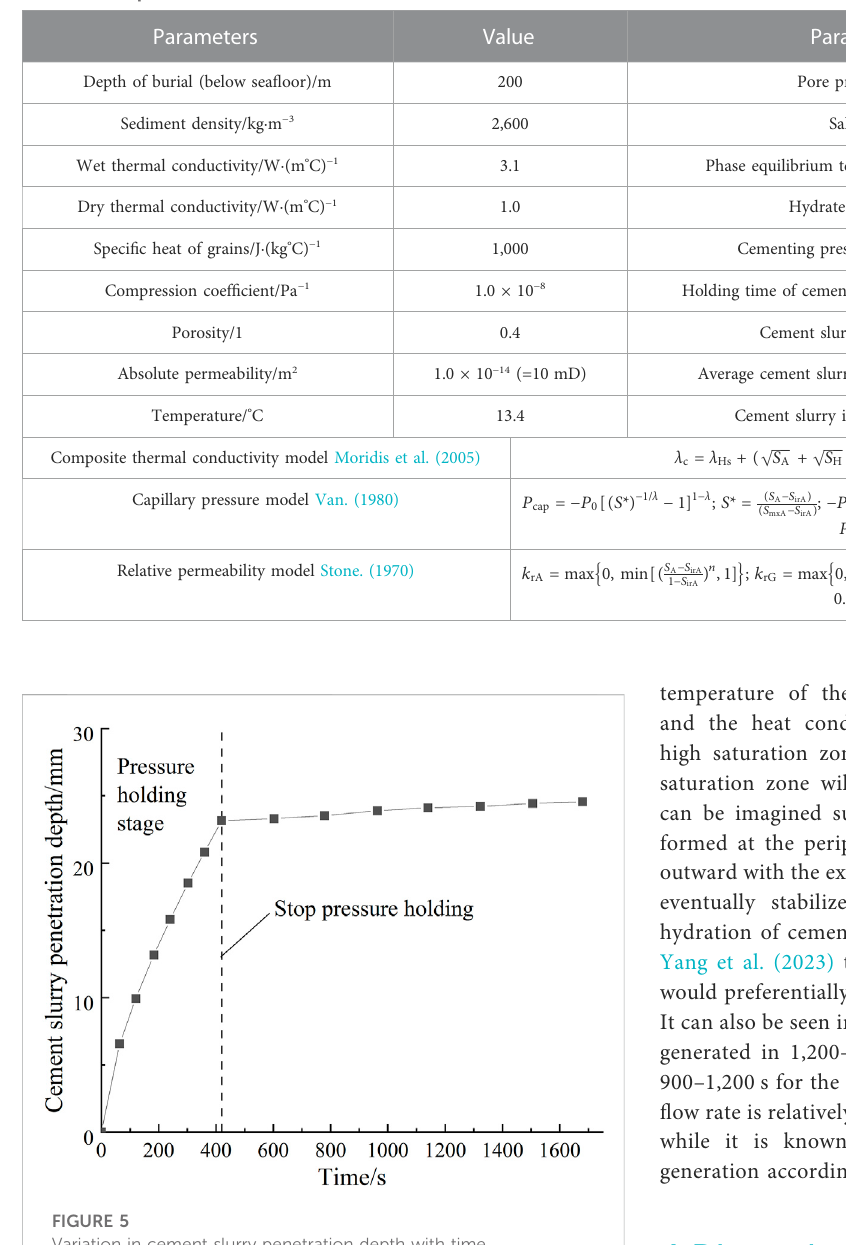
TABLE 2 Main parameter values of the numerical simulation.